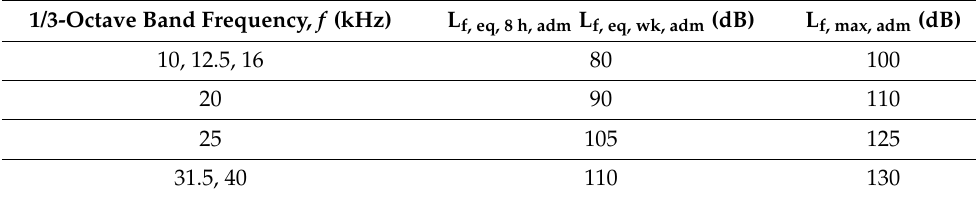
Table 6. Maximum admissible Intensities (MAI): Value for Ultrasonic Noise [80]. 1/3-Octave Band Frequency, f